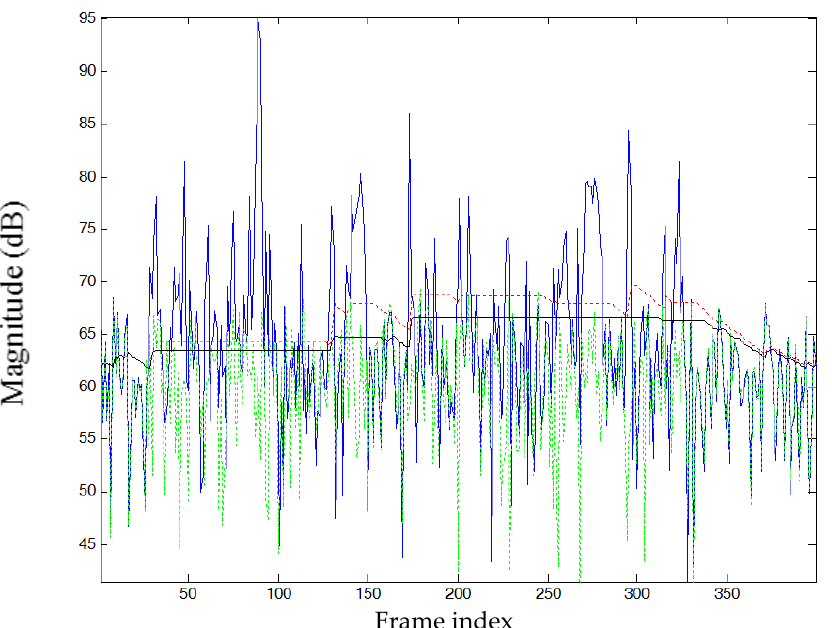
Figure 2. Contours of estimated speech-presence probability. ( a ) Local power of a sub-band (spoken by a female speaker, interfered by white noise with an average SegSNR = 10 dB); ( b ) speech presence probability estimated by the MCRA estimator; ( c ) speech presence probability estimated by the proposed noise estimator.